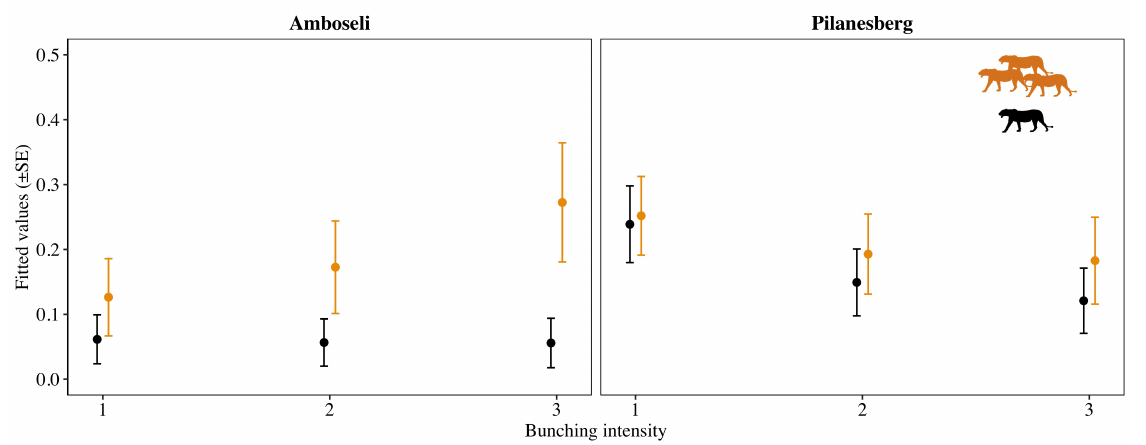
Figure 3. Relative difference in the bunching intensity metric for elephants receiving playbacks of one (black) versus three (orange) lions in Amboseli National Park and Pilanesberg National Park. Lion silhouette illustration was created by